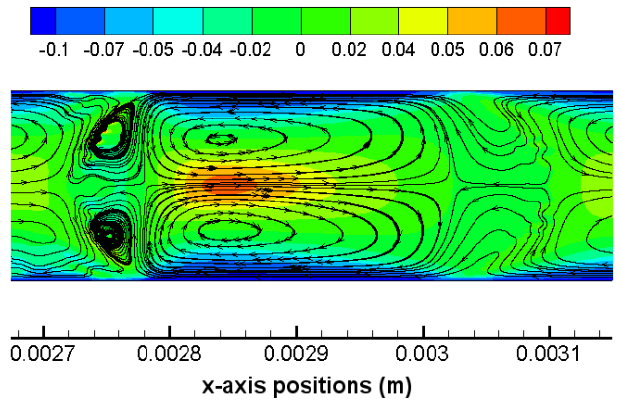
Figure 5. scCO 2 drop at the moment t = 5 ms in simulation Case 4. Contours of relative x -axis velocities (absolute velocities subtracted by v CO = 0.11 m/s) and flow streamlines are shown. Color levels of the band indicate the value of the relative x -axis velocity.